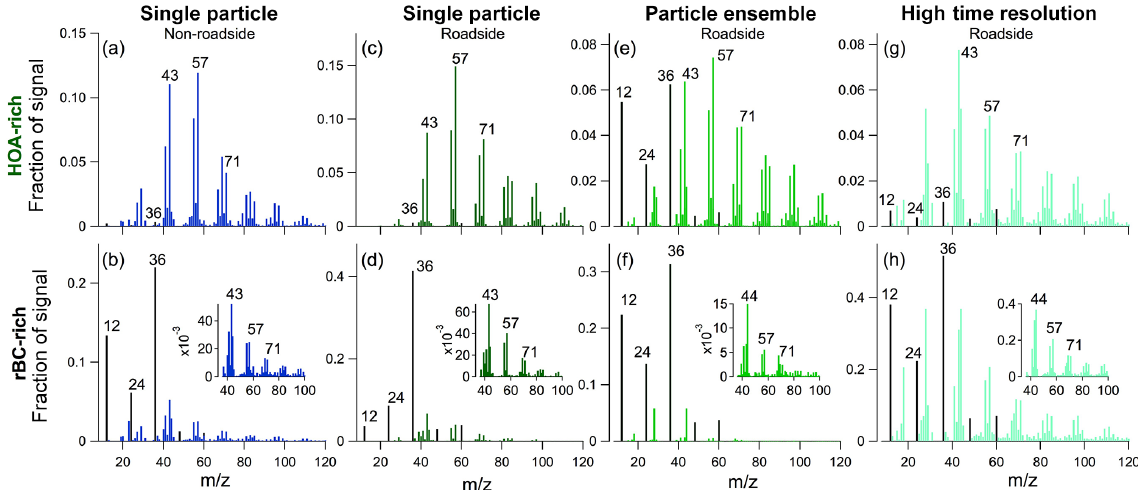
Figure 1. Unit mass resolution (UMR) spectra of HOA-rich (a) and rBC-rich (b) particle classes identified by k -means cluster analysis of single particle SP-AMS data acquired in the non-roadside environment. UMR spectra of HOA-rich (c) and rBC-rich (d) particle classes identified from single particle data in the roadside environment. High-resolution mass spectra of HOA-rich (e) and rBC-rich (f) PMF factors from ensemble SP-AMS data from the roadside study (i.e., for rBC-containing particles only). Examples of UMR spectra collected at high time resolution during HOA-rich (g) and rBC-rich (h) plumes (corresponding time series are shown in Fig. 6) during the roadside study. Insets in the lower panels illustrate the UMR spectrum of organic species (without CO + x fragments) in the rBC-rich mass spectra. Black and coloured sticks represent the fragments of rBC (C + x ) and organic species (C x H + y ,C x H y O + w ),